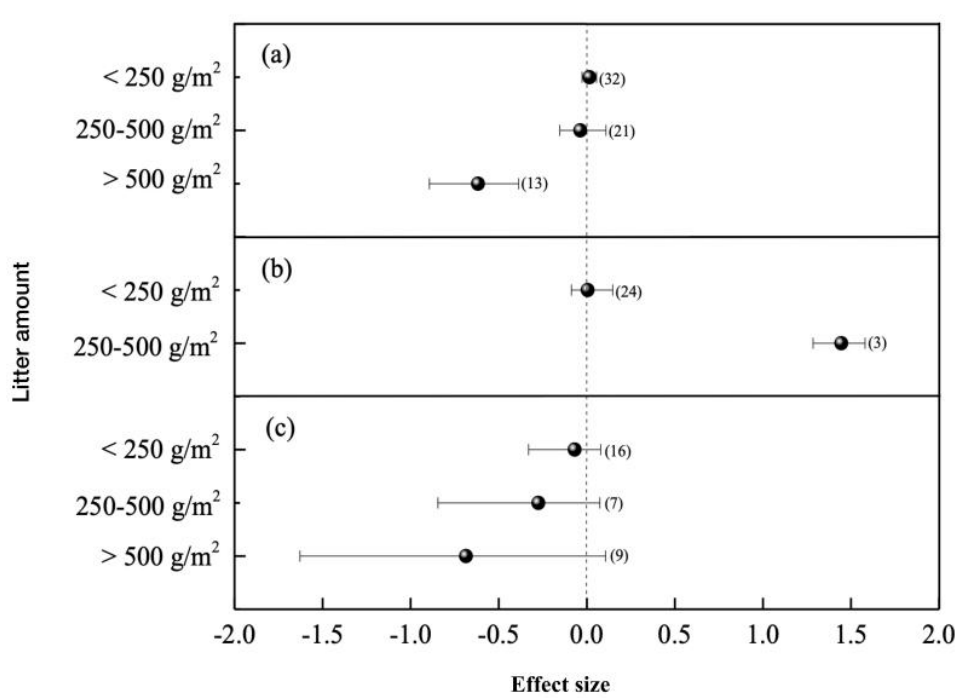
Figure 6. Mean effect size of litter amount on seedling emergence under greenhouse ( a ), field ( b ), and germination chamber ( c ) studies. Note that data on thin and medium thicknesses were included in field studies due to lack of studies on thick litter layer under this condition. Error bar represents 95% confidence interval.